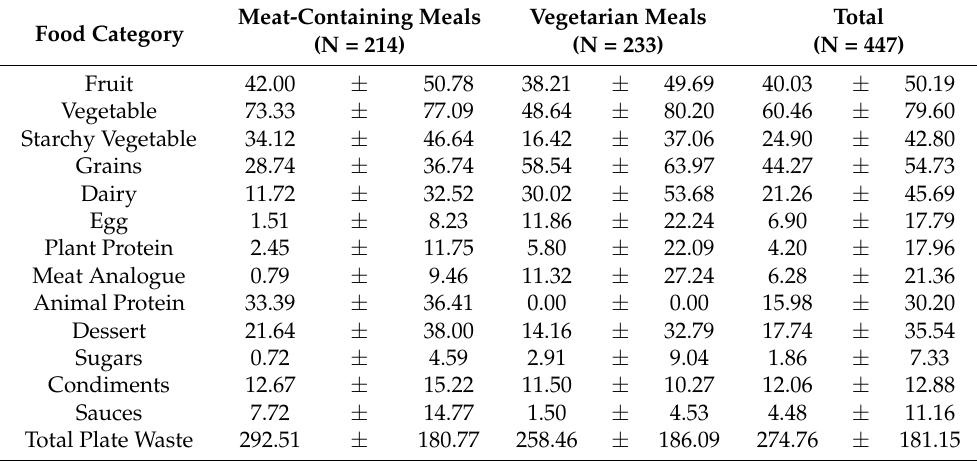
Table A1. Descriptive statistics for plate waste (g/plate) by meal type and food category, presented as M ± SD.